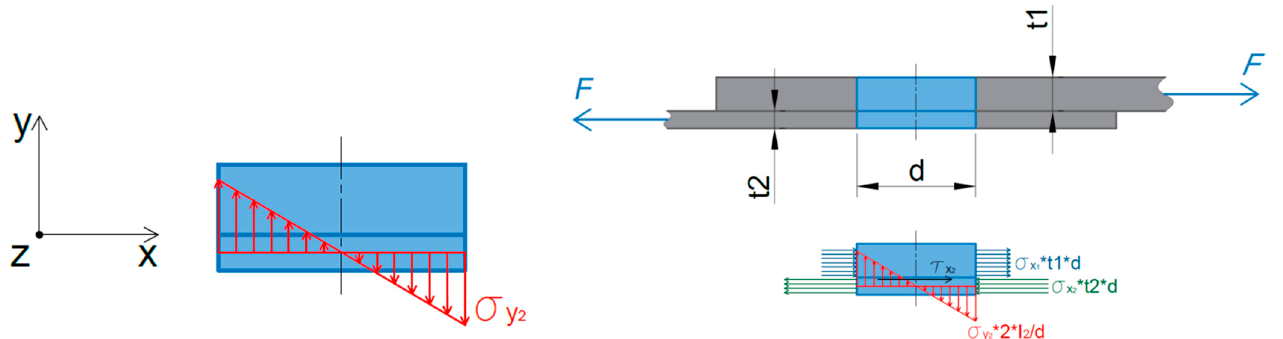
Figure 16. Stresses in a lap joint due to uniaxial tensile force.